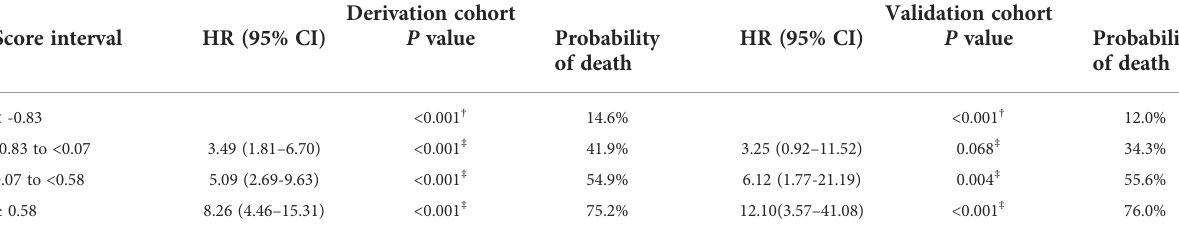
TABLE 5 The probability of death within 90 days after endobiliary stent placement in the derivation and validation cohorts.